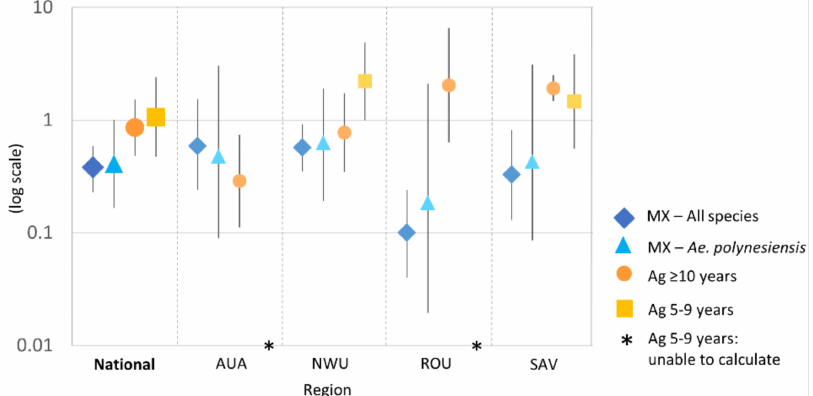
Figure 7. Change in prevalence from 2018 to 2019 in Samoa, expressed as an odds ratio (OR), for mosquito infection prevalence (MX for all species and Ae. polynesiensis ), and human antigen preva- lence (in those aged ≥ 10 years, and 5–9 years). Given the low prevalence, the ORs are approximately equal to prevalence ratios. ORs < 1 indicate decrease in infection prevalence in 2019 compared to 2018, ORs > 1 indicate an increase, and OR of 1 indicate no change. OR could not be calculated for 5–9-year-olds in AUA and ROU because no antigen-positive cases were detected in these groups in 2019. AUA = Apia Urban Area; NWU = North-West Upolu; ROU = Rest of Upolu; SAV =